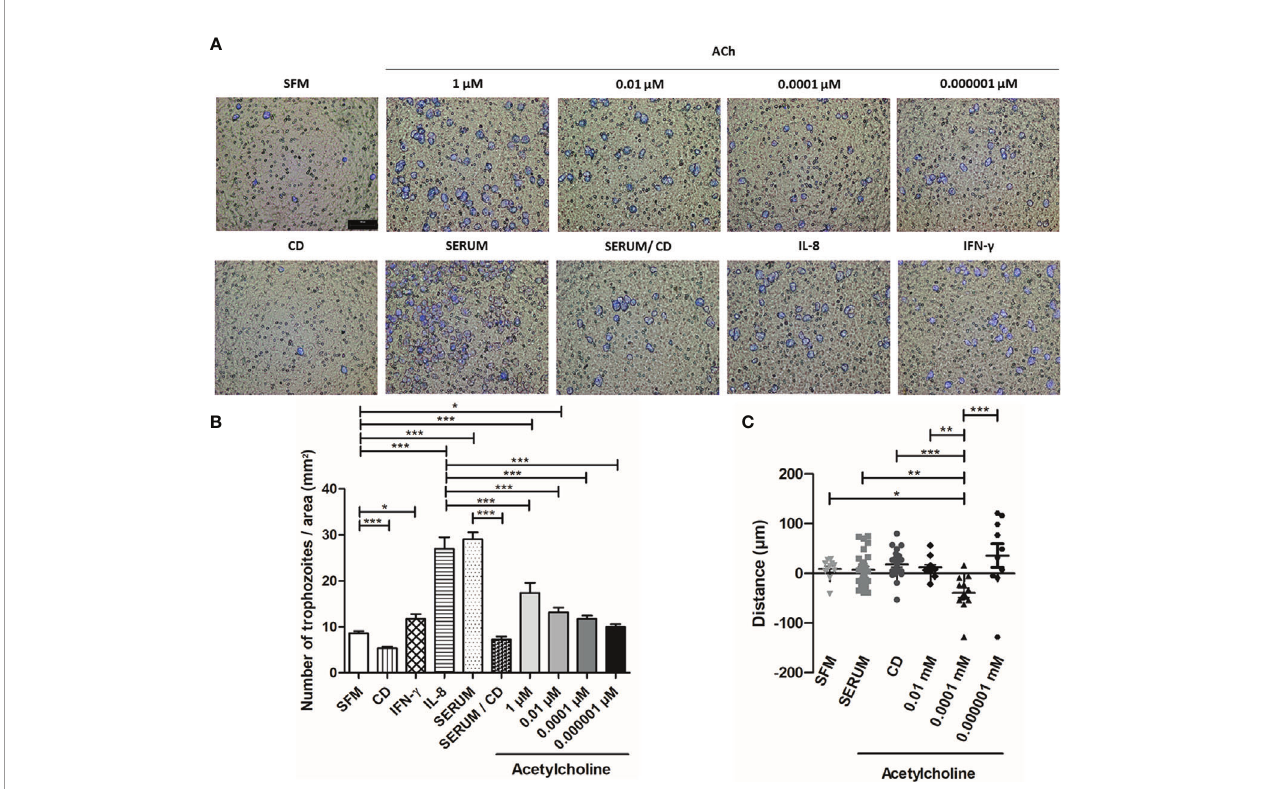
FIGURE 9 | Acetylcholine induces E. histolytica migration and chemoattractant activity. (A) Representative images of the analysis by fl uorescence microscopy at X10 are shown. (B) Number of trophozoites per area (mm 2 ), that migrated through the transwell chamber in the presence of ACh, serum, IL-8 and IFN- g . (C) Distance and direction of amebic movements towards ACh ( Supplementary Video ). Data correspond to the mean ± SEM of three independent experiments (n = 3). The statistical analysis was performed with the One-way ANOVA and Tukey or Kruskal Wallis and Dunn posttest method, respectively, where the values of *p < 0.05, **p < 0.01 and ***p < 0.001 were considered signi fi